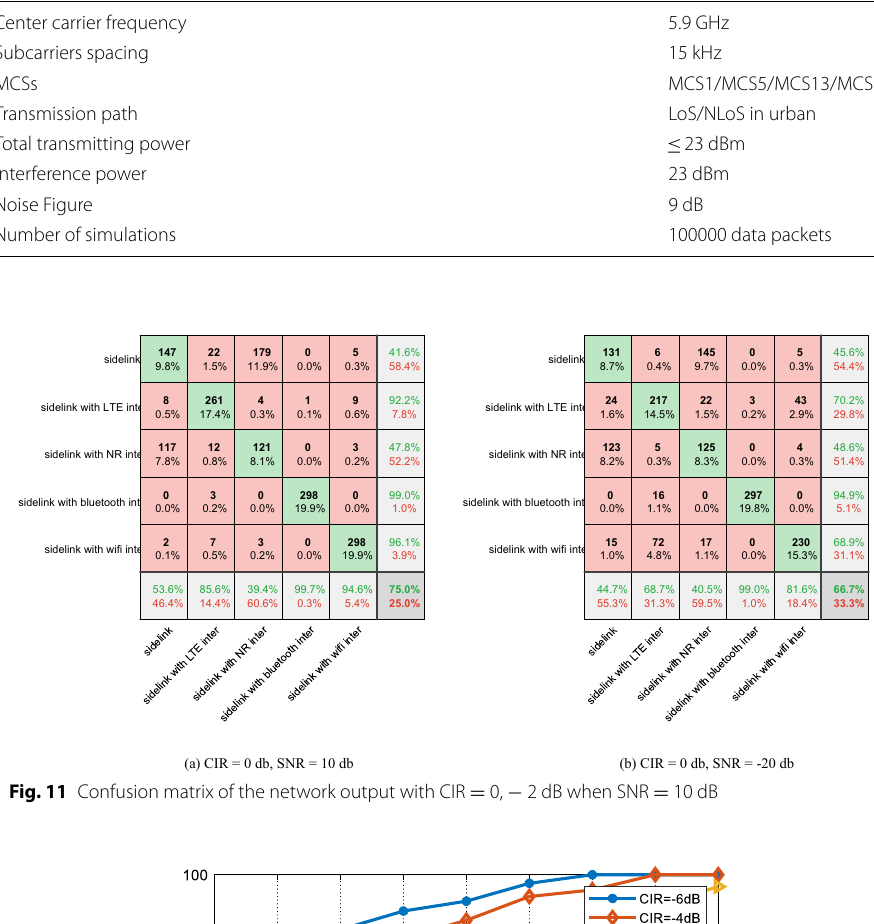
Table 4 Parameters of system-level simulation Paramaters